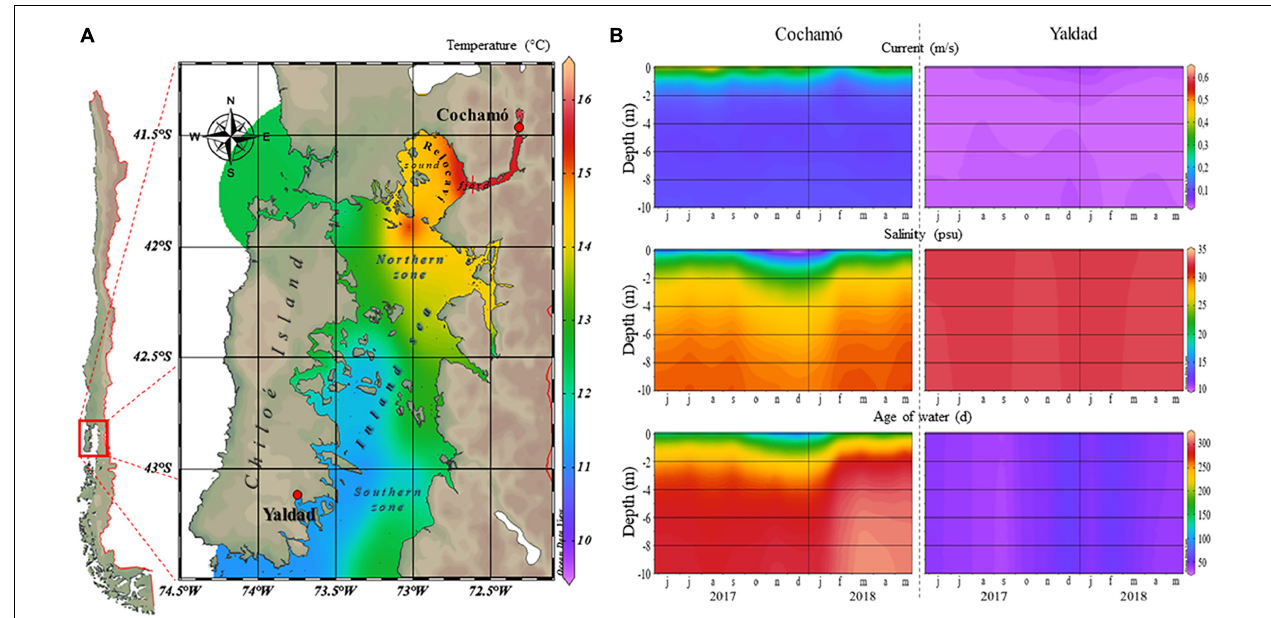
FIGURE 1 | (A) A map indicating the geographical locations of the samplings, Cochamó (north) and Yaldad (south), and seawater temperature for March 2018. (B) Seawater conditions variations between June 2017 and May 2018.